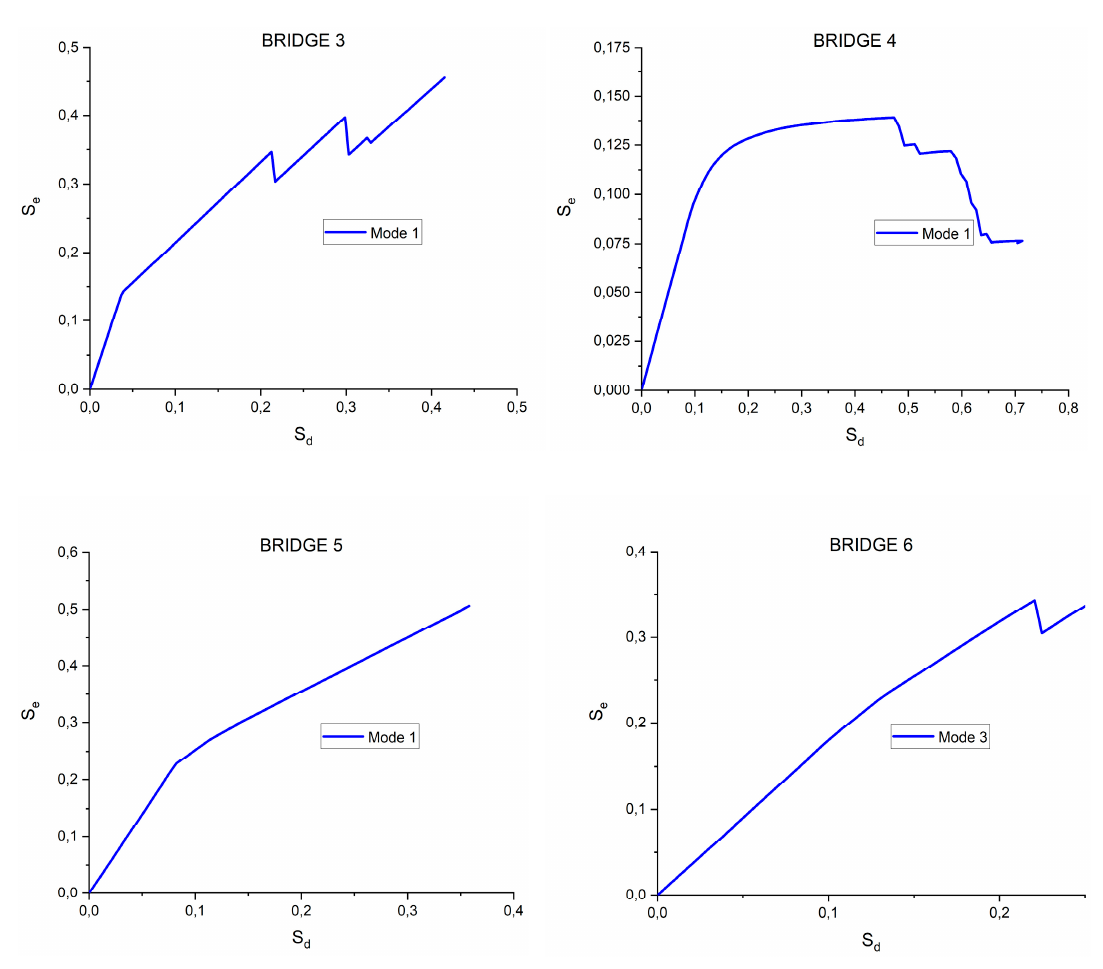
Figure 12. Capacity curves for ductile mechanism (S e [1 / g]–S d [m]). Table 5. Risk indexes for ductile mechanism.